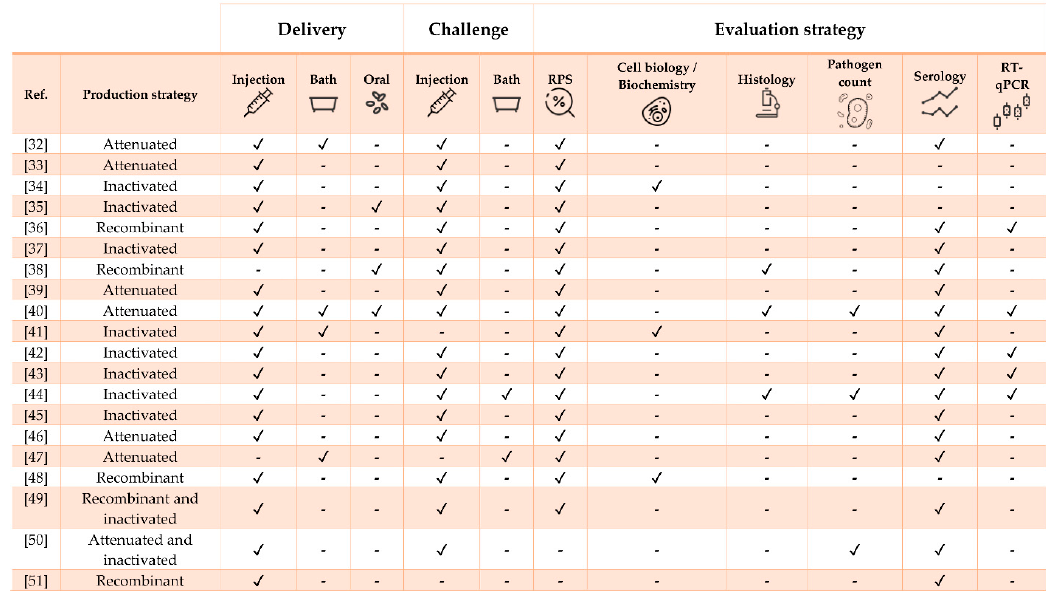
Figure 2. Strategies for vaccine development, administration, and evaluation applied by referenced studies on Nile tilapia Oreochromis niloticus .